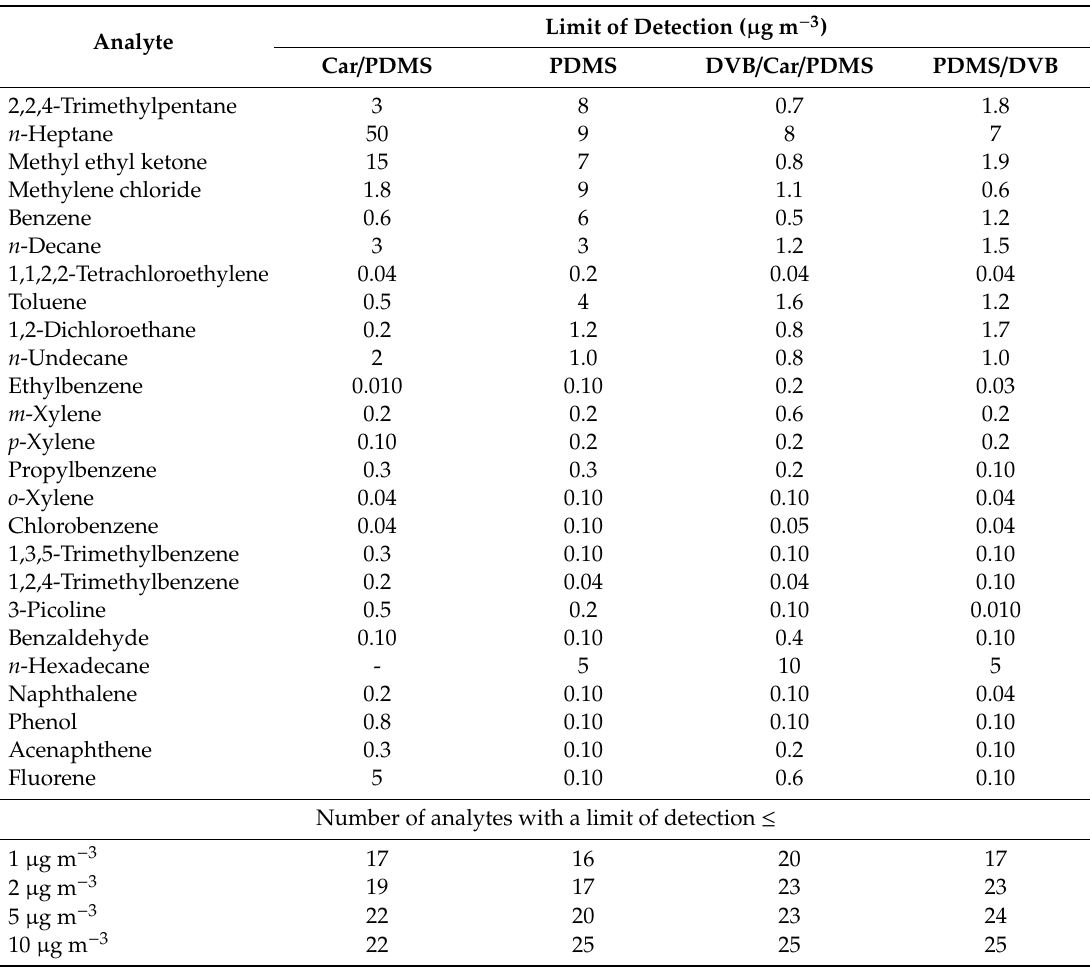
Table 3. Limits of detection obtained using di ff erent SPME fibers.